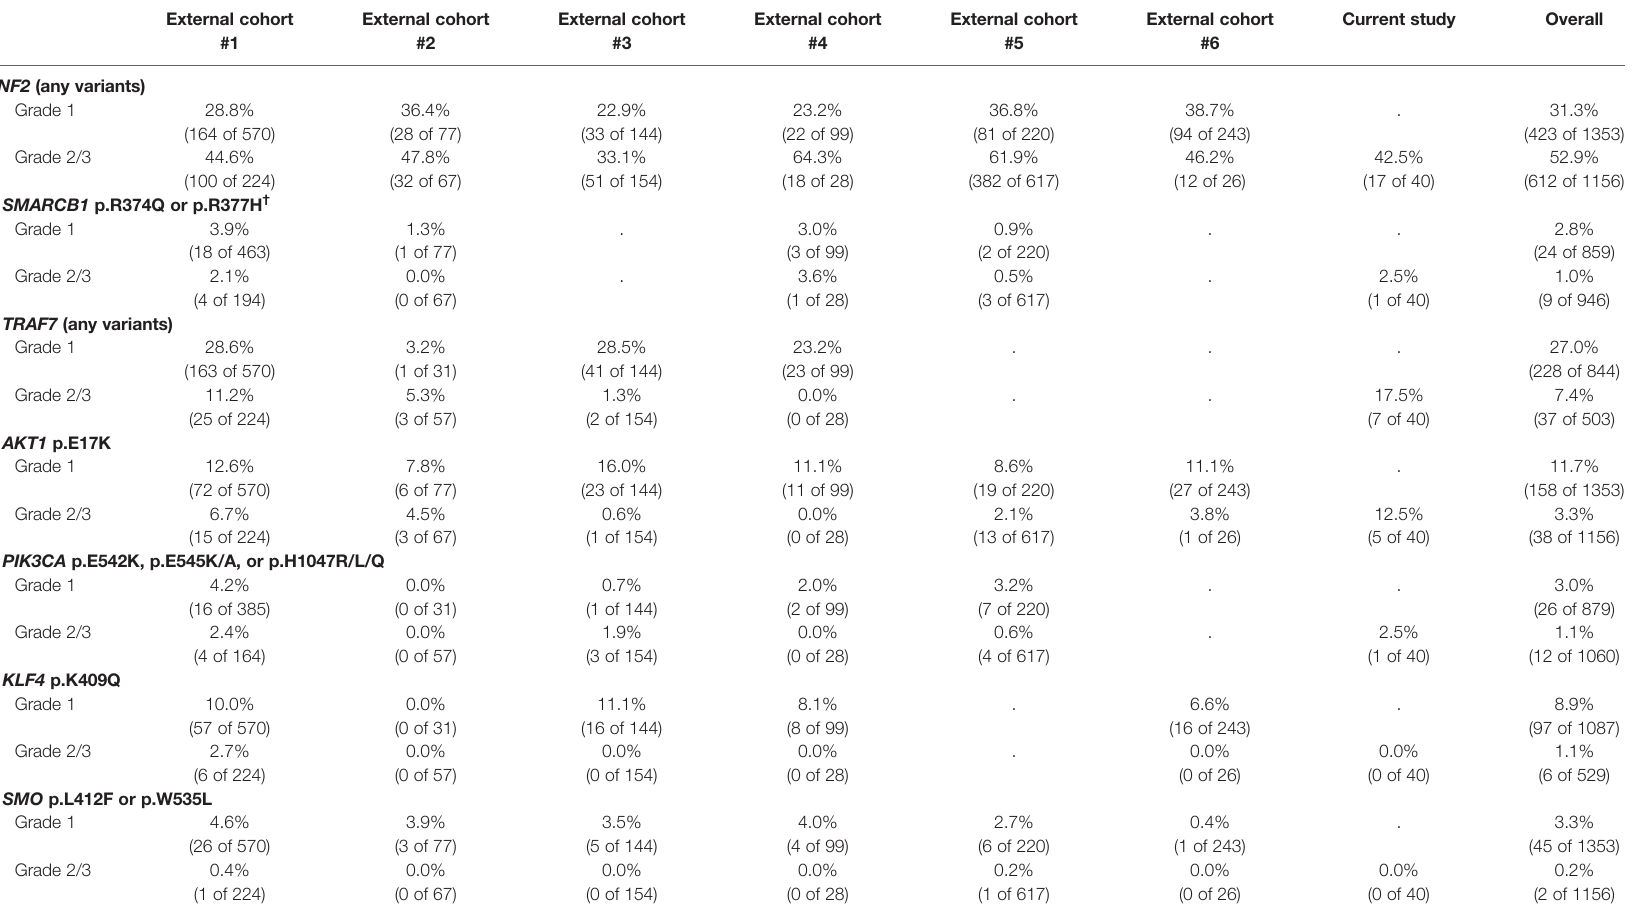
TABLE 2 | Prevalence of recurrent variants in meningiomas according to the histopathologic